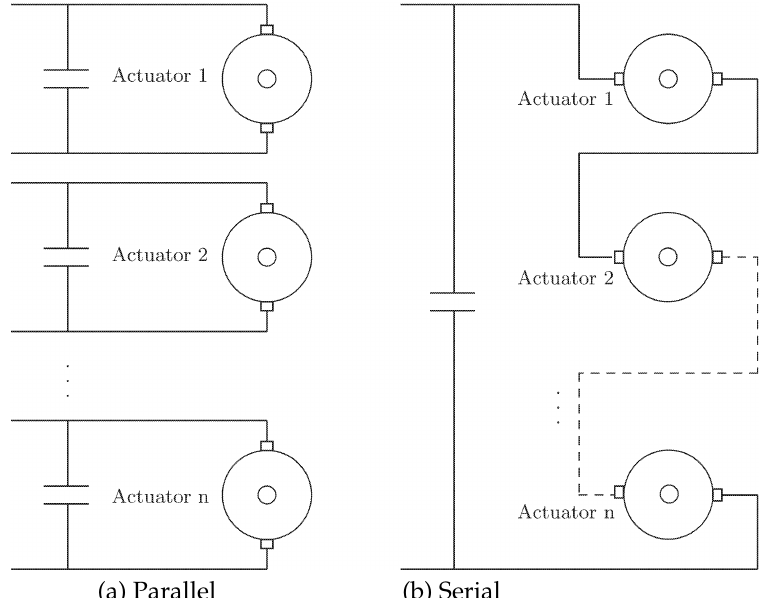
Figure 5. SparkJet arrays in parallel and serial.